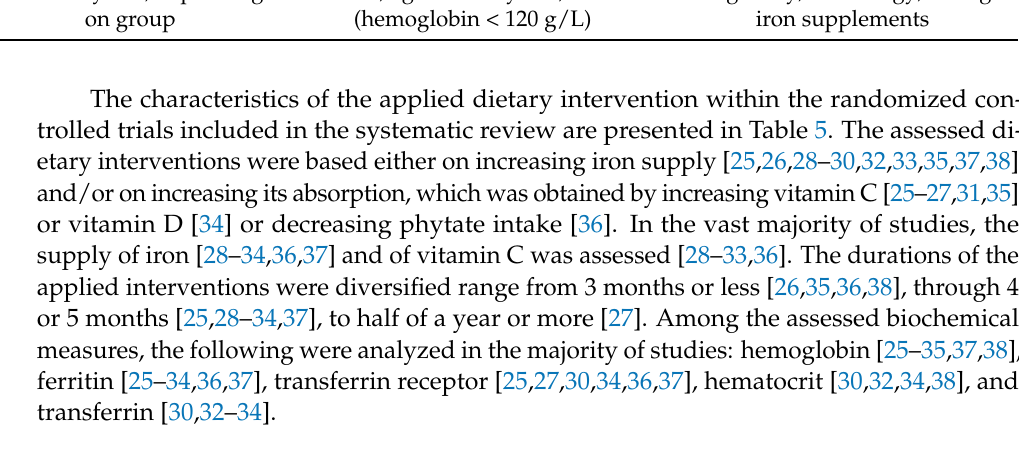
Table 5. The characteristics of the applied dietary intervention within the randomized controlled trials included in the systematic